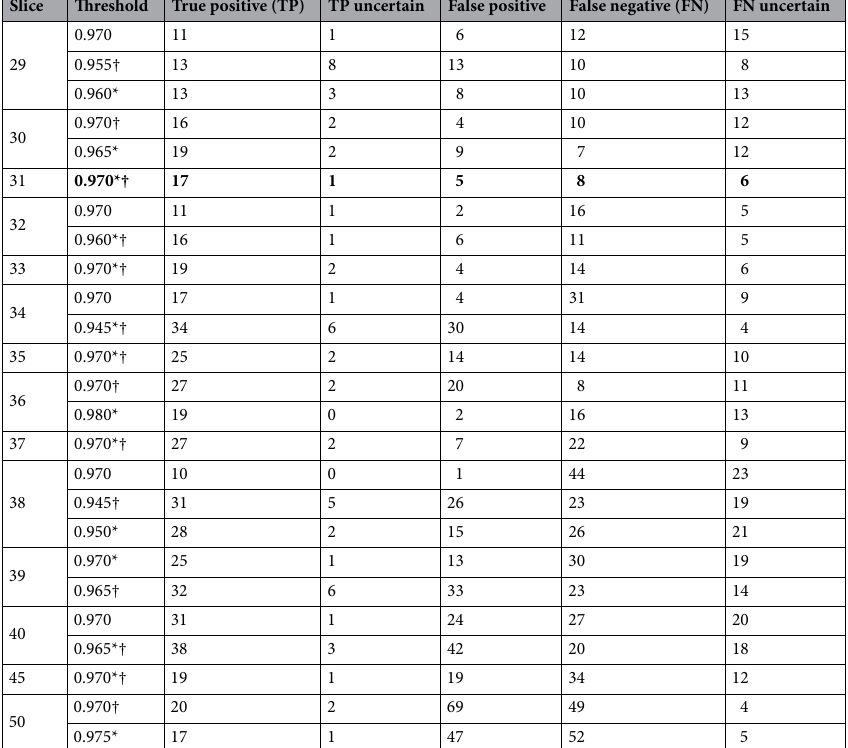
Table 1. Comparison of true positives and misclassifications. The comparison uses the global relative quality threshold 0.97 and the slice specific best threshold (indicated by * without uncertainty and by † with uncertainty) given by the maximum of the dice coefficient. The overall maximum of the dice coefficient (bold) is given for slice 31 using the threshold 0.970.